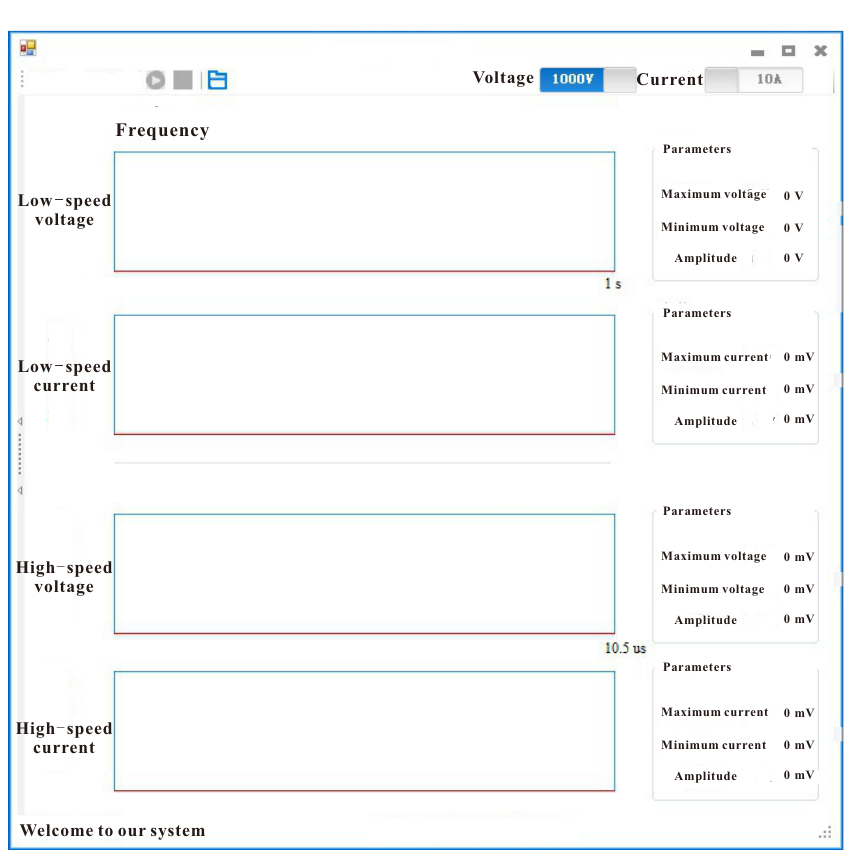
Figure 7. Interface display of the main window form on the upper computer.